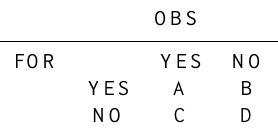
Fig. 3. National Civil Protection warning areas (black contour) and high-resolution non-GTS network (green dots: Piemonte data source, white ones: COSMO consortium, red ones: National Civil Protection Department). Table 1. The contingency table, where A is the number of fore- casted and observed events (hits), B is the number of forecasted but not-observed events (false alarms), C is the number of observed but not-forecasted events (misses), D is the number of not-forecasted and not-observed events (correct negatives).